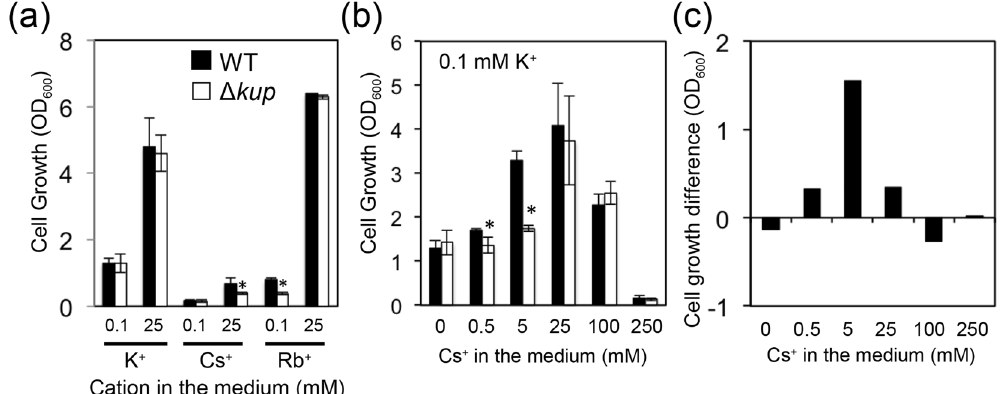
Figure 1. Growth tests of E . coli WT and Δ kup in minimal medium. E . coli WT (black bars) and Δ kup (white bars) grown in minimal medium containing 0.1 mM K + were collected by centrifugation, washed with K + -free buffer, then inoculated into minimal medium supplemented with K + , Cs + or Rb + ( a ), or with 0.1 mM K + and various concentrations of Cs + ( b ). Cell growth was determined after 24 h-incubation at 30 °C. * Represents significance by Student’s t -test comparing WT to Δ kup at the same concentration ( P < 0.05). ( c ) Difference in growth (OD 600 ) between WT and Δ kup calculated from the data in Fig.